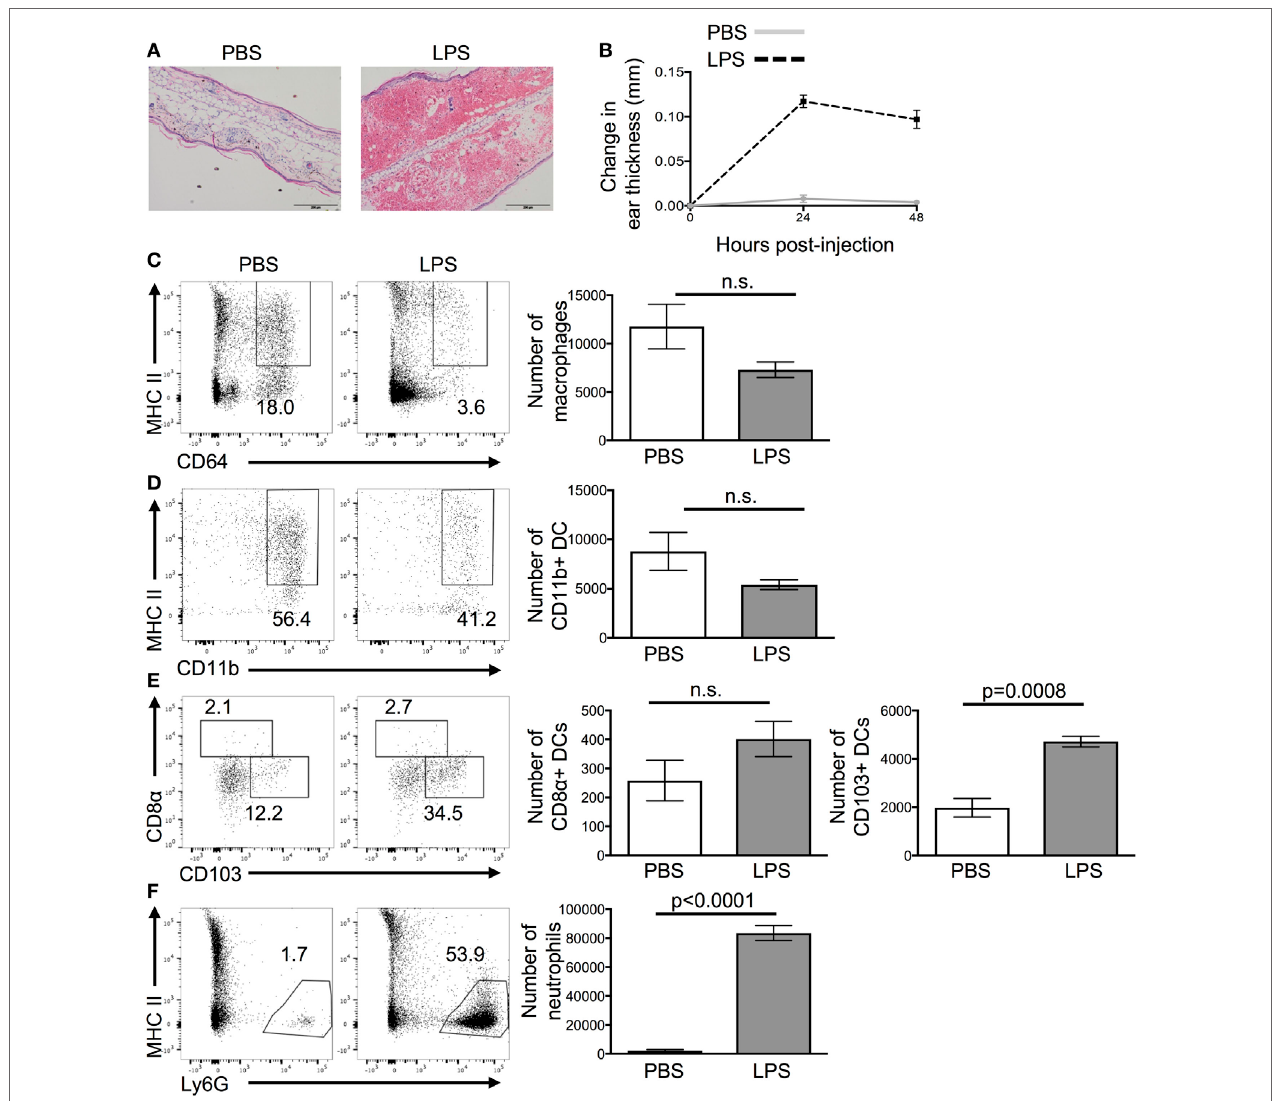
FigUre 1 | Lipopolysaccharide (LPS) injection into the ear causes extensive cellular infiltrate. 24 h after the injection of PBS or LPS into ear pinnae, the response was examined by microscopy (a) , digital calipers (B) , or flow cytometry (c–F) . Representative images of H&E stained sections (a) or homogenized ears (c,D) are shown. In panel (a) , the scale bar shows 200 μ m. In panel (B) , an average of three individual measurements was taken for each ear pinnae. In panels (c,e) , cells are gated on live cells, in panel (D) on live CD45 + CD11c + cells and in panel (F) on live CD45 + CD11c + MHCII + cells. Data are representative of two independent experiments with three to five animals per group. Error bars show